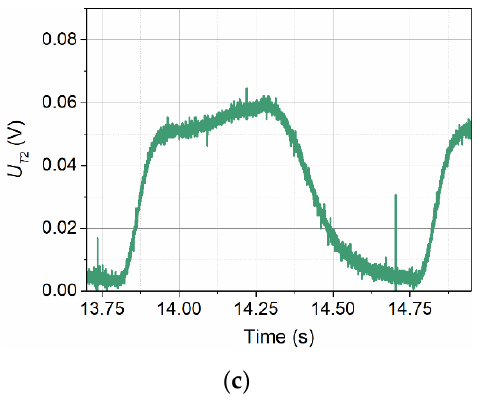
Figure 6. Pulse shapes recorded by detector T2 for three thermal wave frequencies: f = 0.25 Hz ( a ), f = 0.50 Hz ( b ), and f = 1.00 Hz ( c ), at the inflow velocity v ∞ = 0.065 m/s.